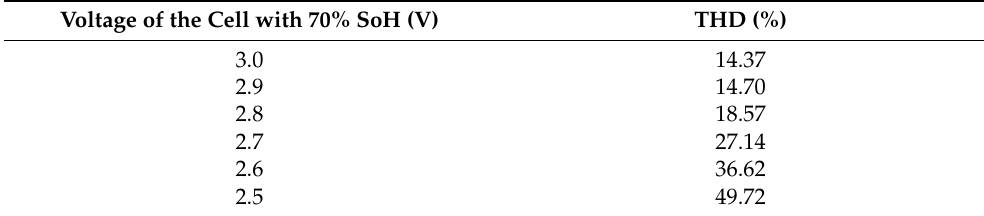
Table 3. THDs of the LIB pack at different cell voltages of the 70% SoH cell. Voltage of the Cell with 70% SoH (V)